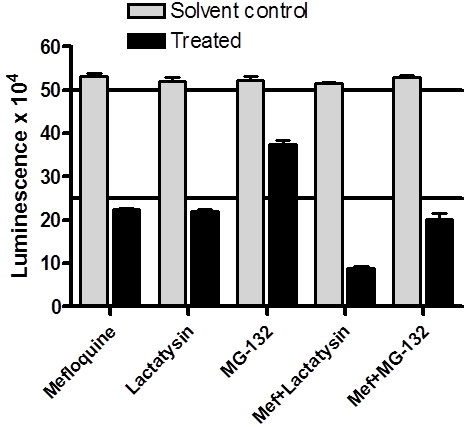
Effect of proteasome inhibitors on mefloquine-induced luciferase activity decrease. Plasmodium falciparum 3D7 parasites expressing firefly luciferase were incubated for 6 hours with 100 nM mefloquine, 5 μM lactacystin or 300 nM MG-132, or with 100 nM mefloquine combined with lactacystin or MG-132 in a 96-well plate. Luciferase activity in drug-exposed (solid bars) and solvent control (shaded bars) cultures was determined with a luminescence based Bright-Glo® Luciferase Assay System reagent (Promega). Individual data-points are mean luminescence values (relative light units – RLU) from three replicate wells and error bars indicate standard deviation.